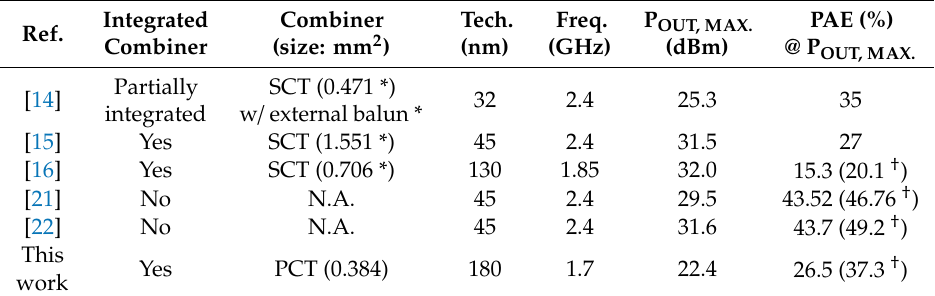
Table 1. Performance comparison with outphasing CMOS